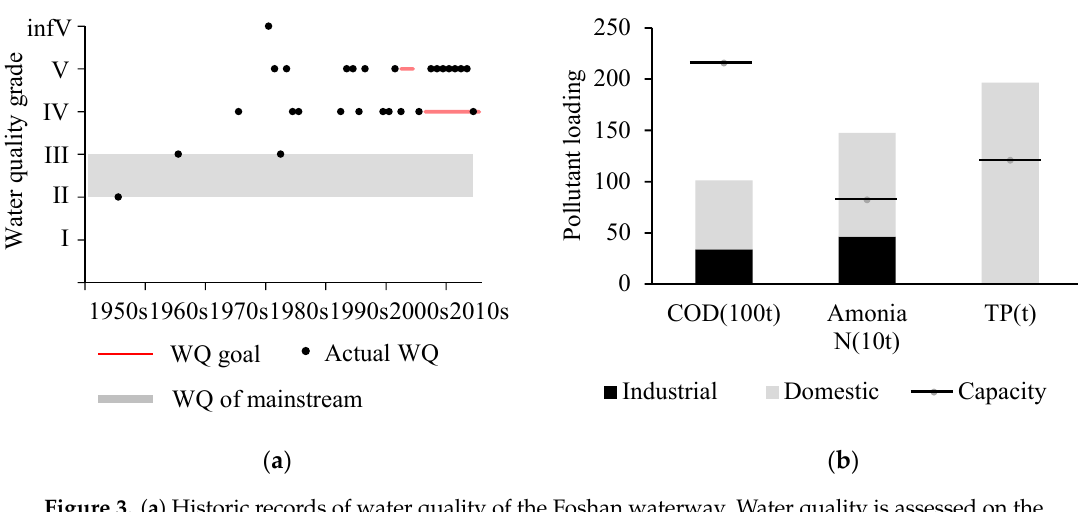
Figure 3. ( a ) Historic records of water quality of the Foshan waterway. Water quality is assessed on the bases of six grades with functions of drinking water sources (Grades I to III); general water use in industry, recreation, or agriculture (Grades IV–V); and harmful water for direct contact (Grade infV). (Source: Foshan Yearbook 1993–2015). ( b ) Water pollution source and environmental capacity. The